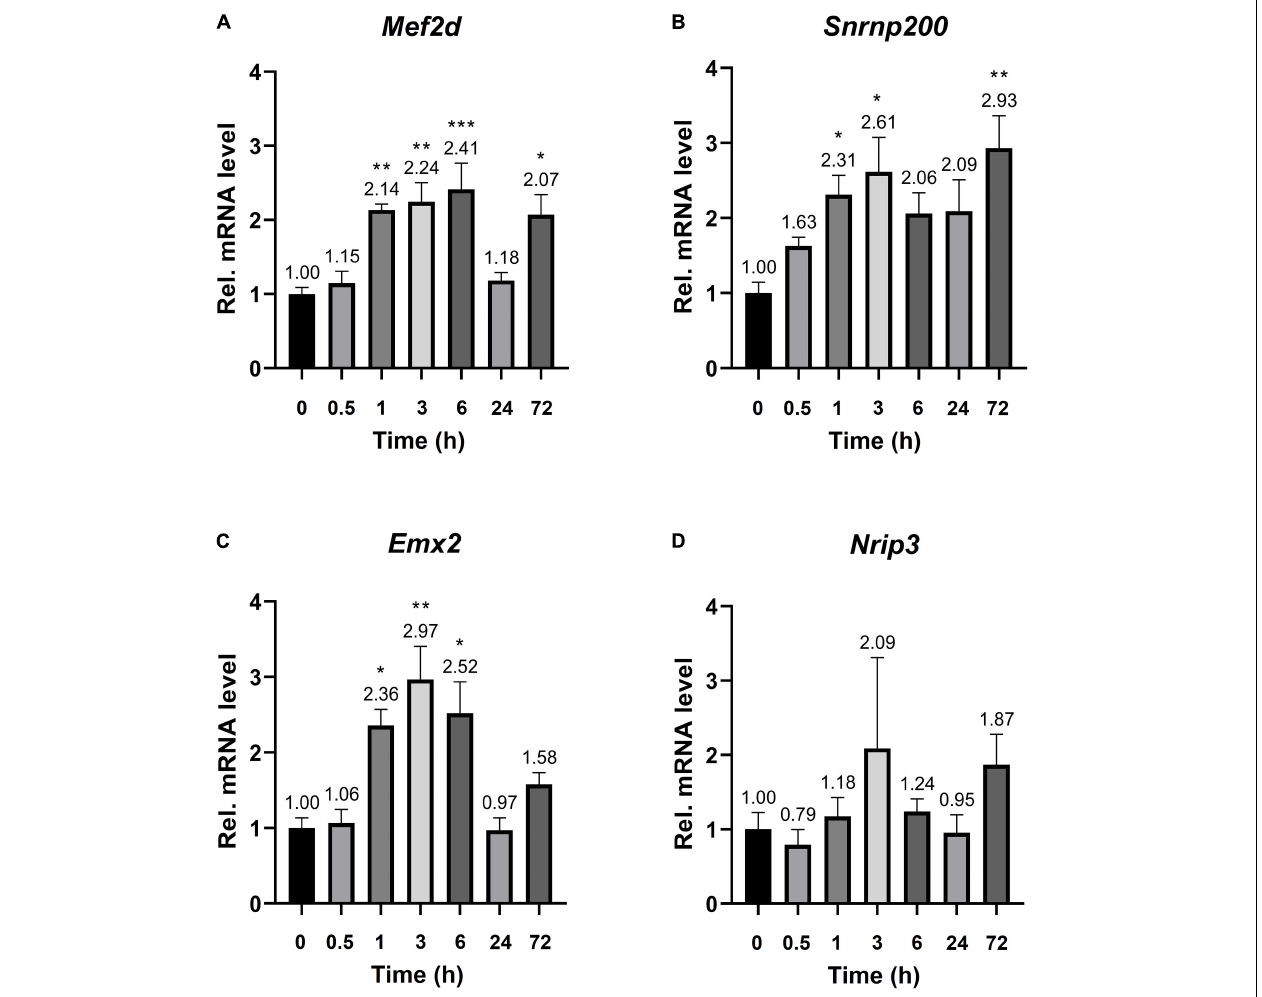
FIGURE 5 | mRNA expression of the Plaur-miR1-3p and Plaur-miR1-5p target genes Mef2d , Snrnp200 , Emx2, and Nrip3 in mouse striatum. qPCR analysis of (A) Mef2d , (B) Snrnp200 , (C) Emx2 and (D) Nrip3 expression in the striatum of control mice (treated with saline, 0 h) and mice 0.5, 1, 3, 6, 24, and 72 h after endogenous Plaur induction. The data are presented as mean ± SEM ( n = 4), normalized to Actb (encodes β -actin) expression as a reference gene. The data were analyzed by using analysis of variance followed by Dunnett’s multiple comparisons test with GraphPad Prism software. Statistical significance is indicated by bars and asterisks as follows: * p < 0.05; ** p < 0.01; *** p <